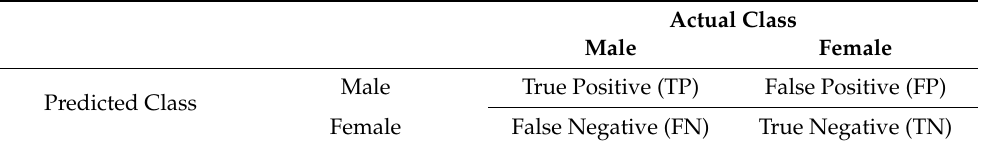
Table 3. The background parameters to describe the performance metrices for the classification model.